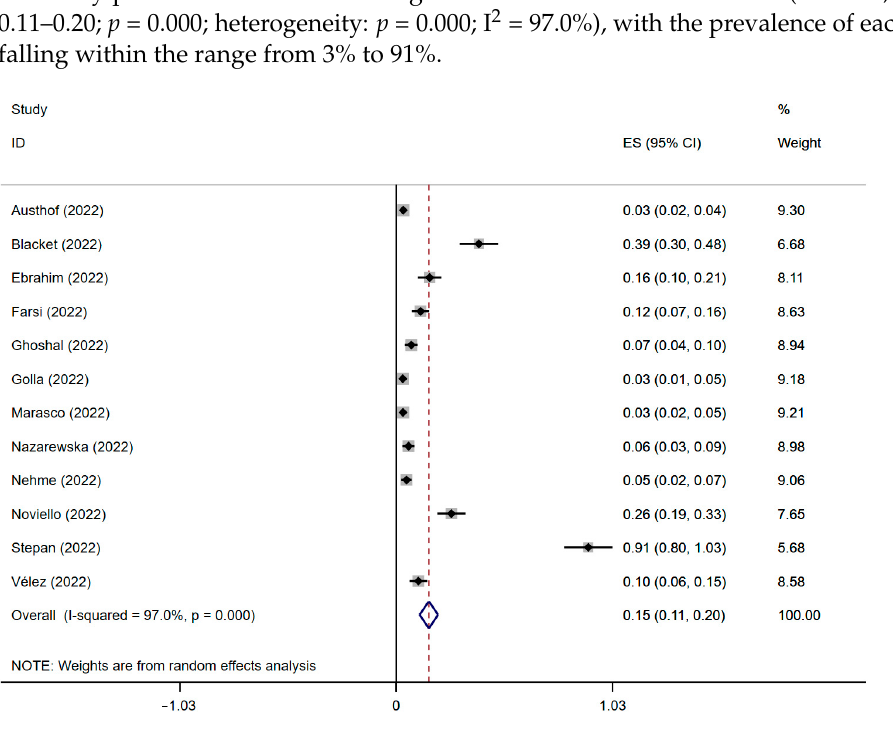
Figure 2. Forest plot of the IBS prevalence after SARS-CoV-2 infection [19–24,33–38]. IBS, irritable bowel syndrome; SARS-CoV-2, severe acute respiratory syndrome coronavirus 2; ES, effect size.